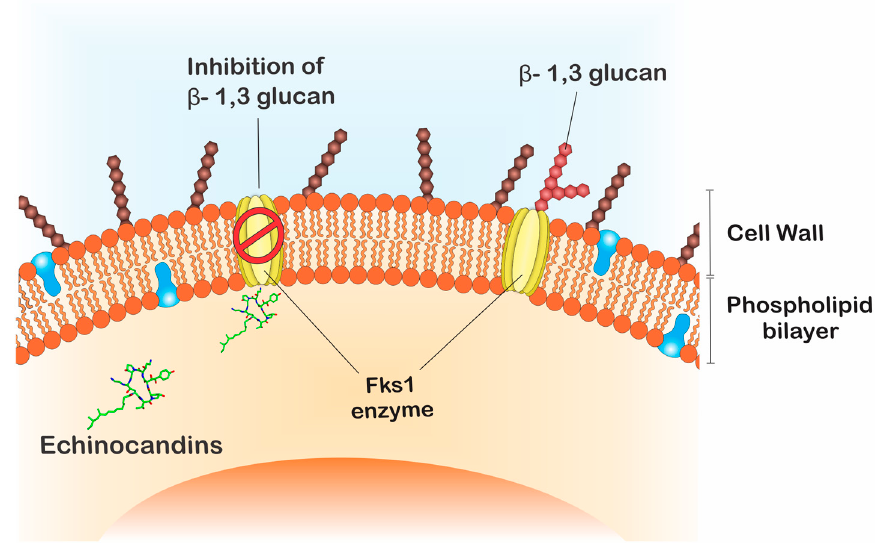
Figure 2. Echinocandins’ mode of action. Fks1 is essential for the catalysis of β -1,3-glucan, an important component of the fungal cell wall. Echinocandins acts through the inhibition of β -1,3-glucan